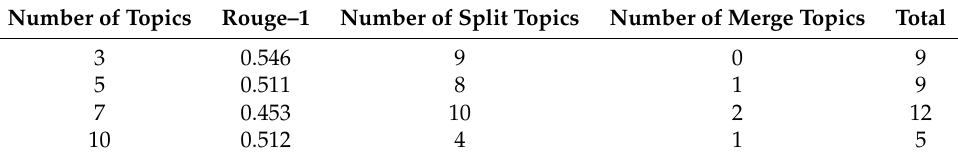
Table 3. The optimal number of